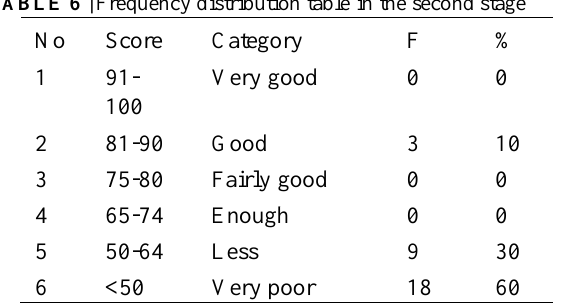
TABLE 6 | Frequency distribution table in the second